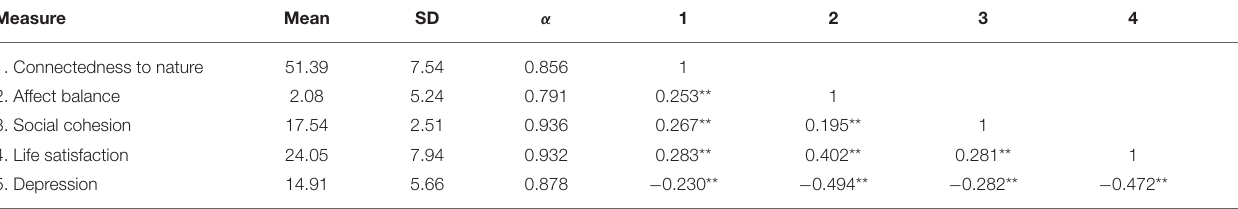
Sample sizes: n = 675. α , Cronbach’s alpha.